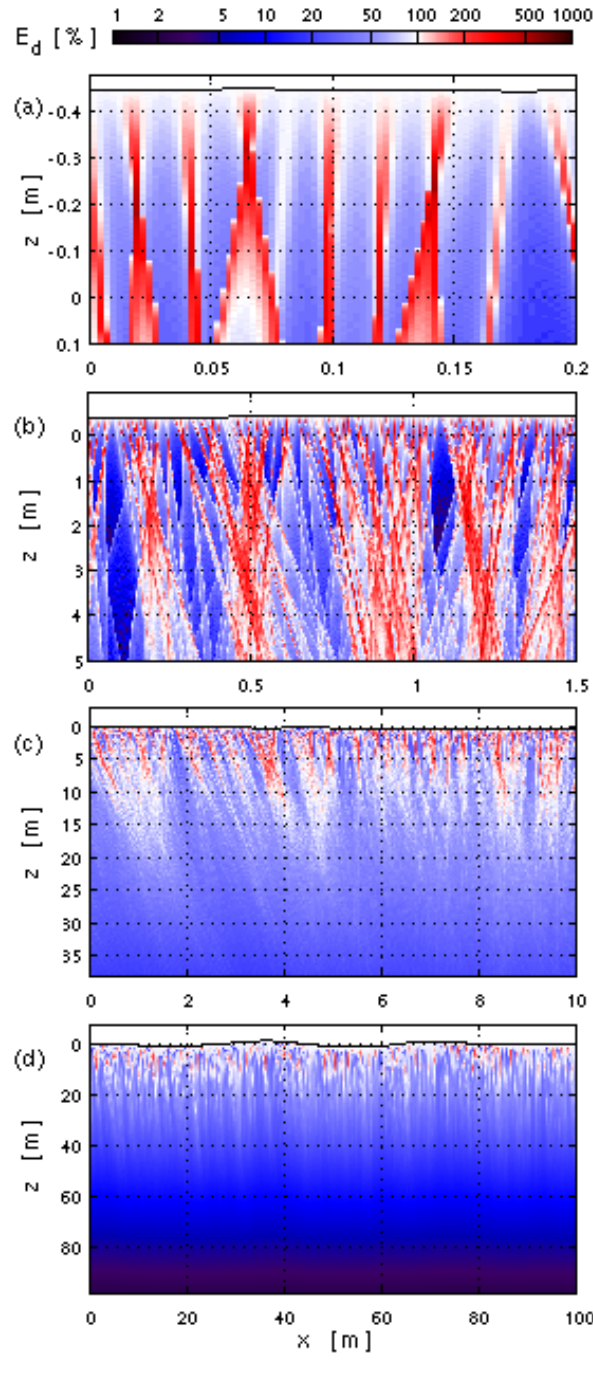
Fig. 5. Downwelling irradiance distributions beneath an irregu- Figure 5. Downwelling irradiance distributions beneath an irregular wave profile 3 lar wave profile according to the conditions on 30 October 2009; (a) and (b) details from the near-surface model with dx = 2 . 5mm according to the conditions on 30 Oct. 2009; (a) and (b) details from the near-surface model 4 resolution; (c) dx = 1cm; (d) model resolution 10cm (logarithmic color with dx = 2.5 mm resolution; (c) dx = 1 cm; (d) model resolution 10 cm (logarithmic color 5 scale). 6